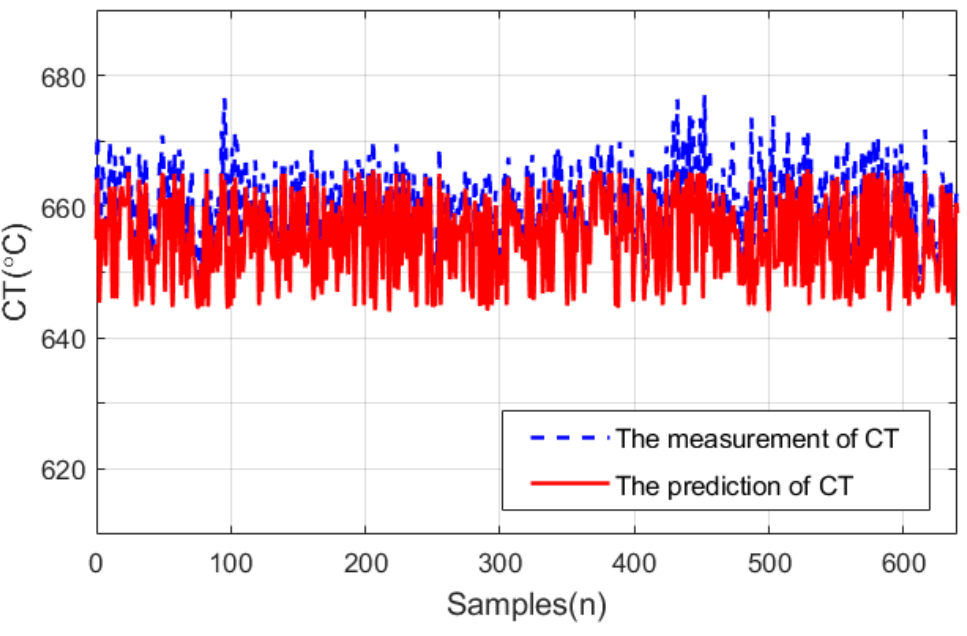
Figure 11. Comparison between the prediction and the measurement of CT with different